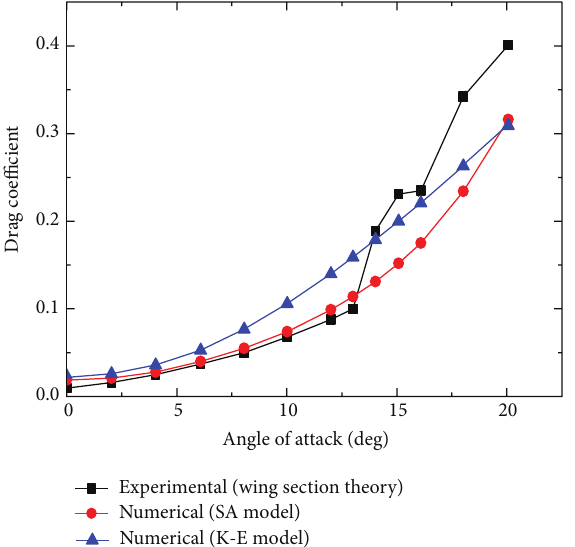
Figure 5: Drag coefficient comparison between numerical and experimental results.